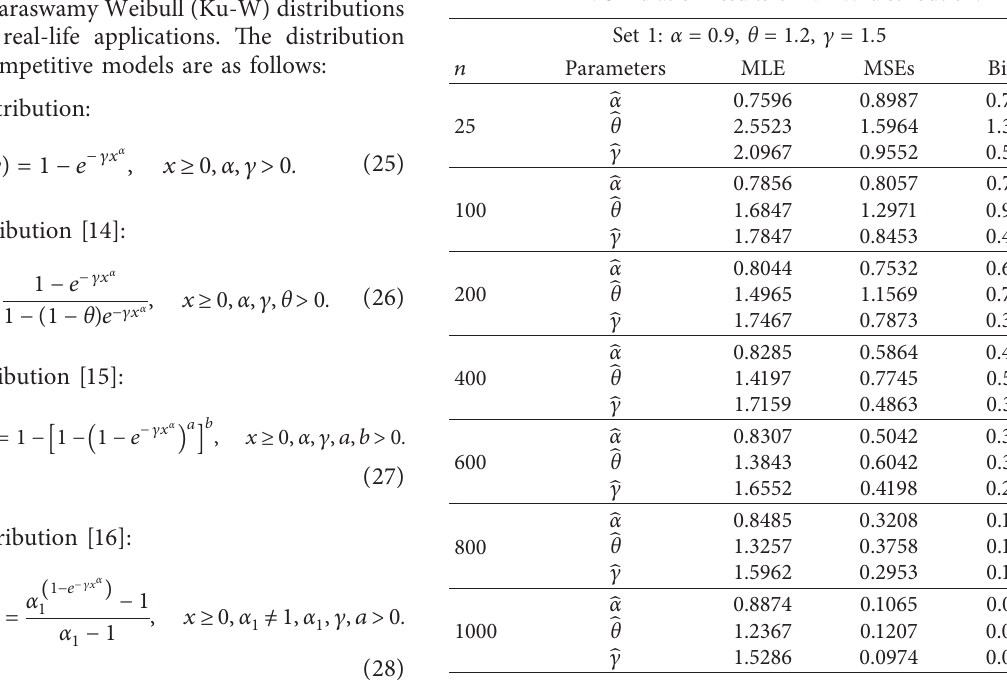
Table 2: Simulation results of NE-W